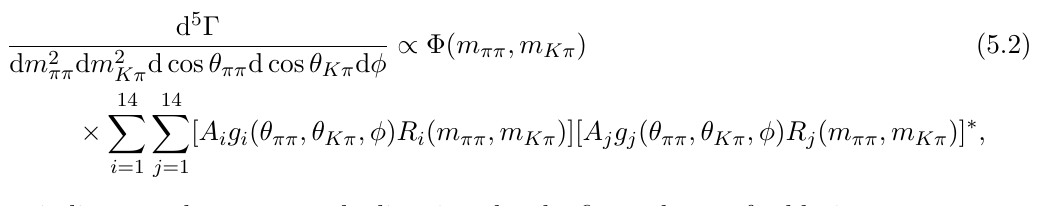
(cid:26) 0 K (cid:3) 0 !